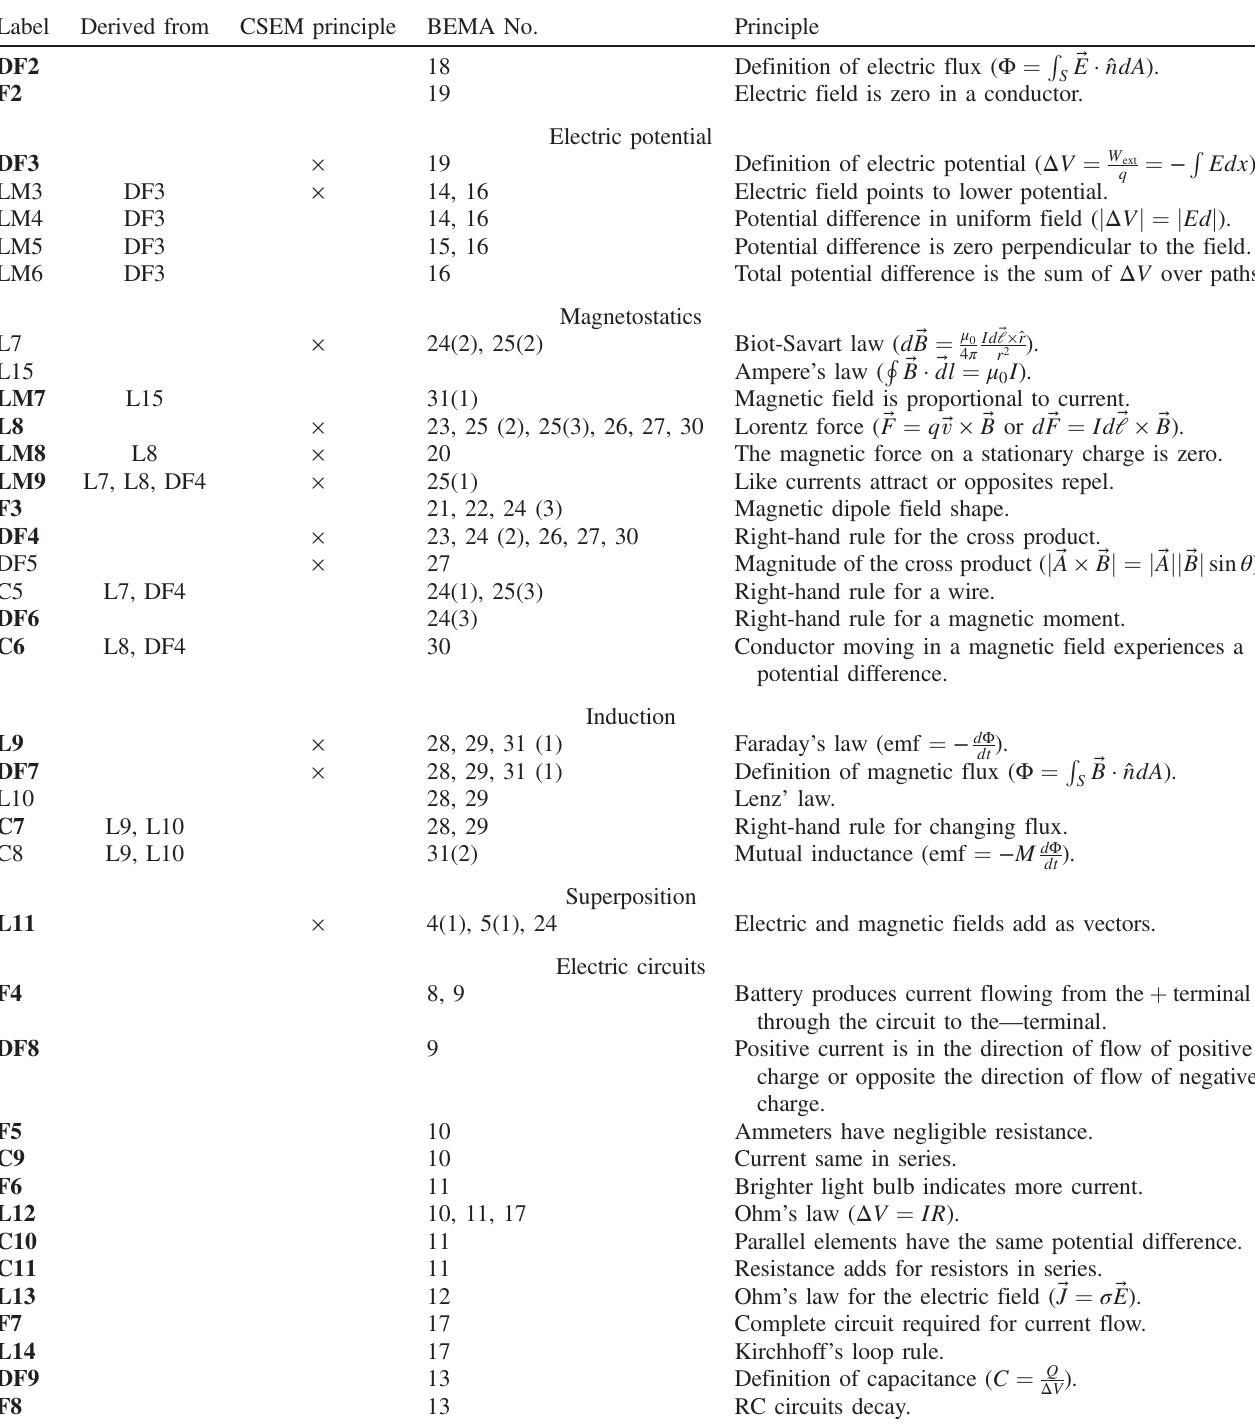
TABLE III. (Continued) Label Derived